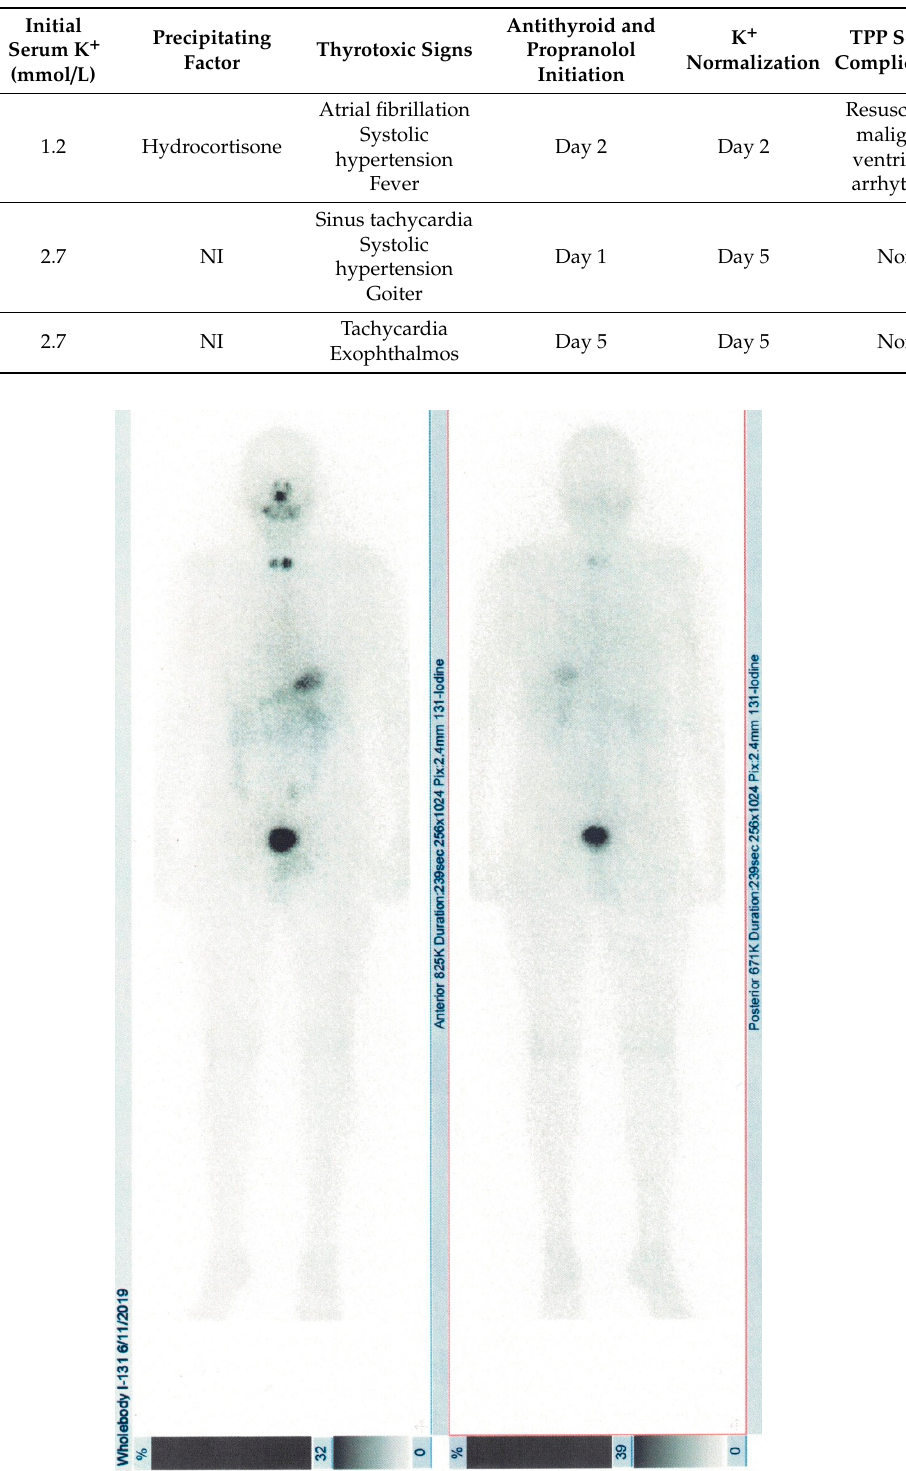
Figure 2. Remnant uptake in the thyroid area after iodine radiopharmaceutical washout in patient 1.